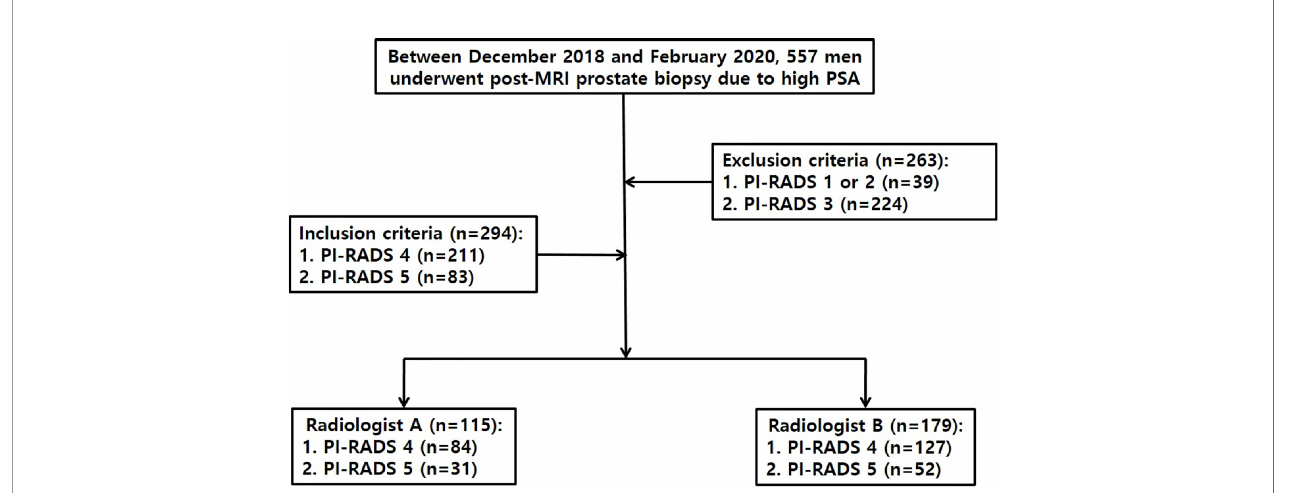
FIGURE 1 | Flow diagram illustrating how to select study